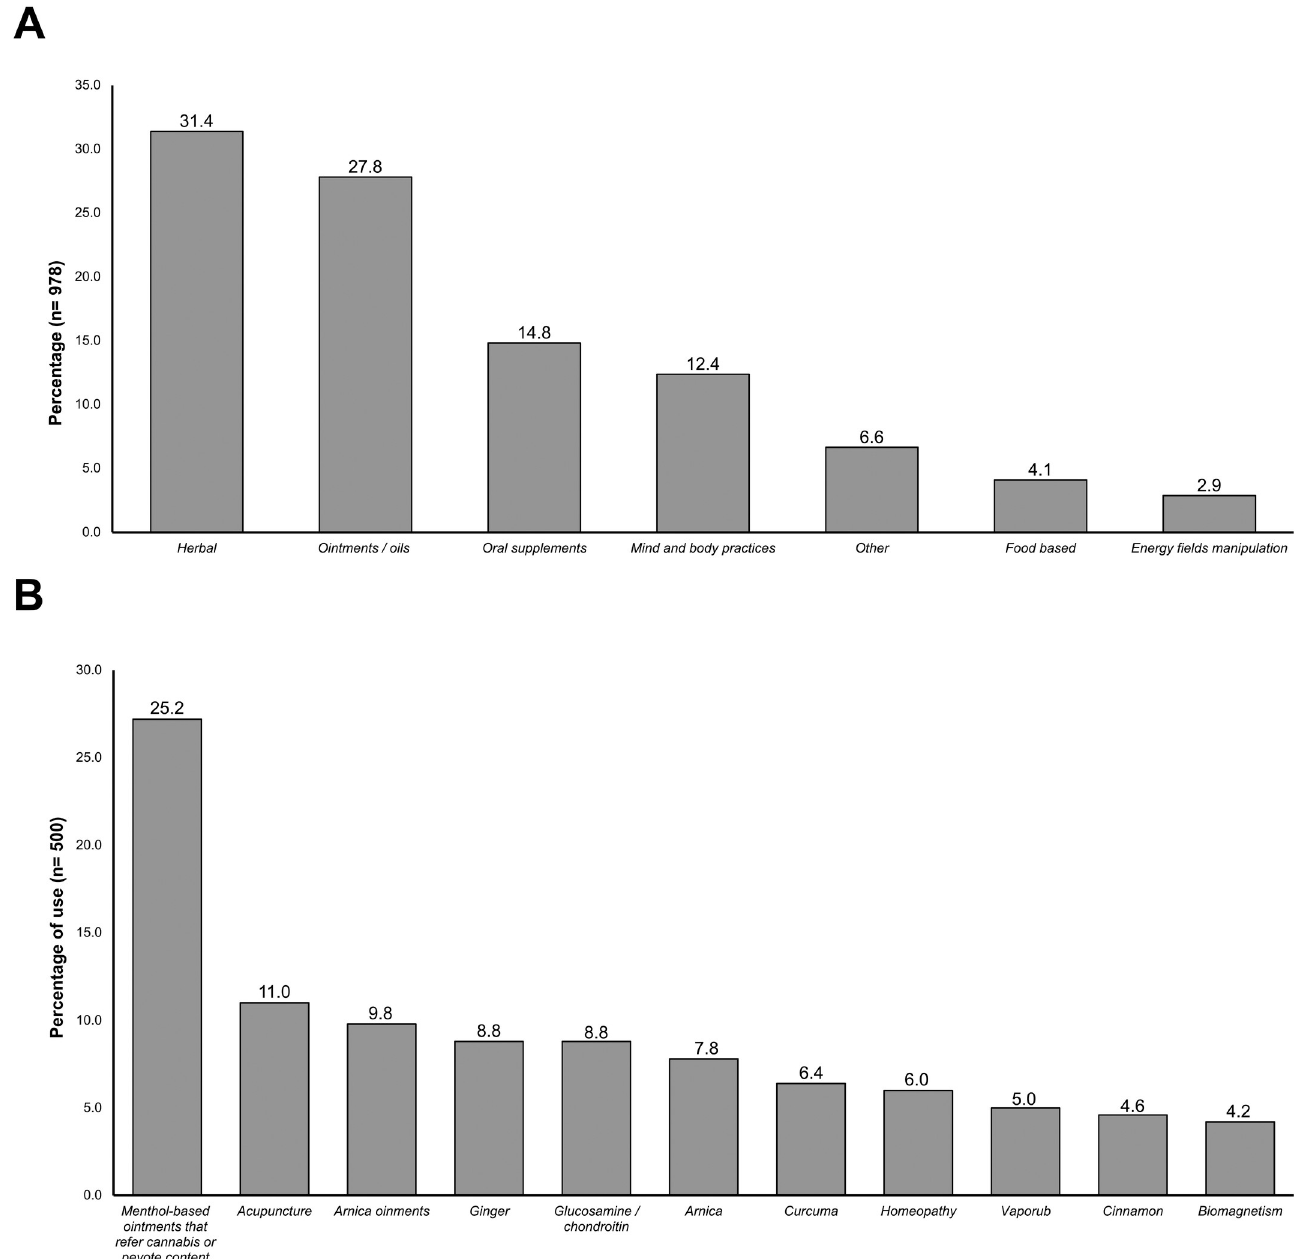
Fig 1. Prevalence of use of CAM therapies in patients with rheumatic diseases. (A) The percentages of CAM use classified in the seven groups are shown; the total number of different therapies reported was 978, the bars indicate the proportion corresponding to each group. (B) The percentages of use of the eleven most used individual CAM therapies in the population (n = 500) are